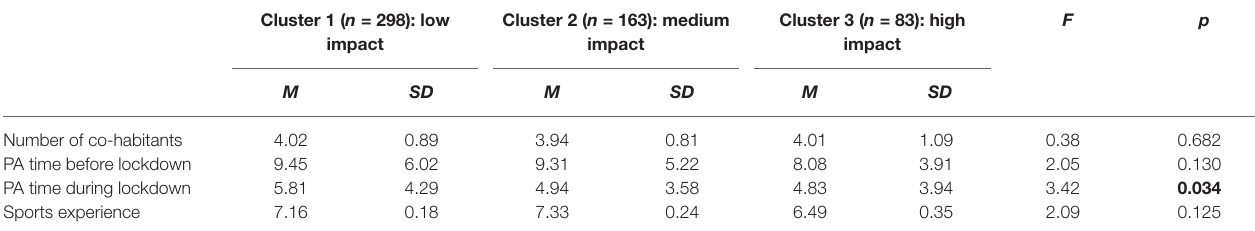
TABLE 3B | Differences in demographic and sports information between clusters (numerical variables).